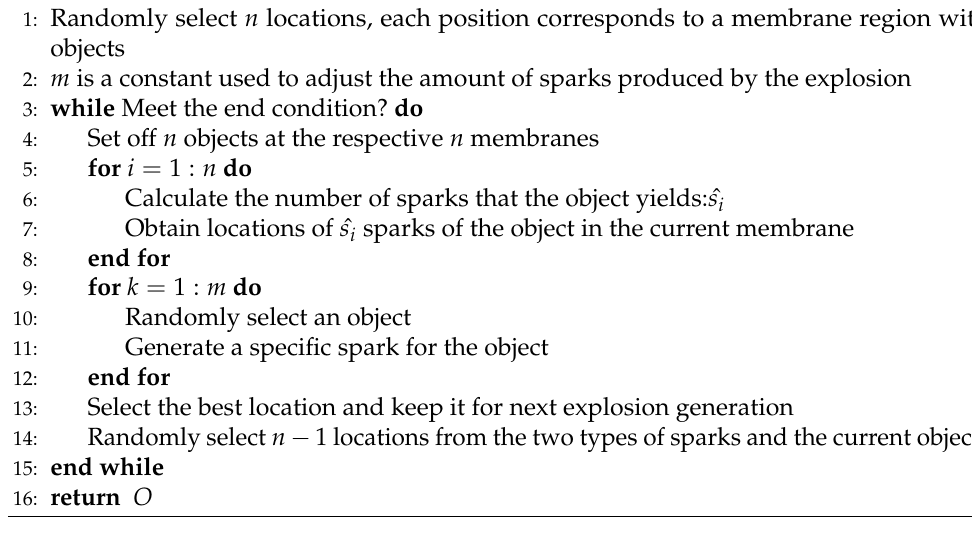
Algorithm 1 Pseudocode for the calling logic of fireworks